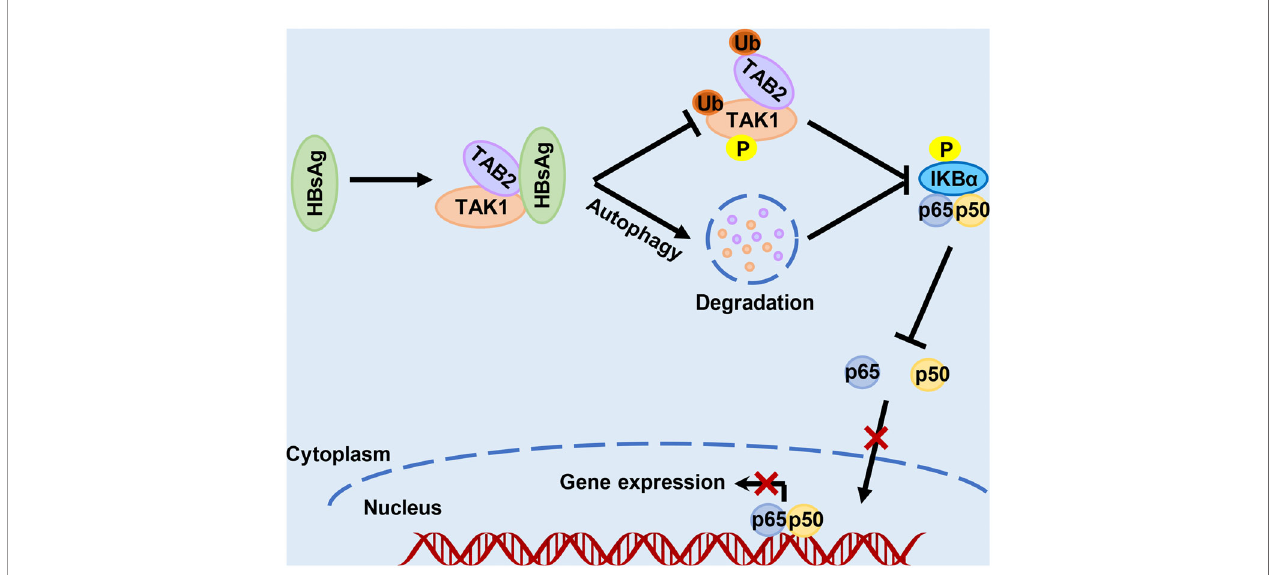
FIGURE 8 | Schematic illustration of how HBsAg interferes with the nuclear factor kappa B (NF- k B) signaling pathway. HBsAg speci fi cally binds to TAK1 and TAB2, suppresses the polyubiquitination of TAK1-TAB2 complex, blocks TAK1 and IKB a phosphorylation, inhibits the NF- k B subunits p50 and p65 translocation from cytoplasm to nucleus, and downregulates the expression of IFNs and in fl ammatory cytokines. On the other hand, HBsAg interferes the molecular interaction between TAK1 and TAB2 with promoting autophagic degradation, further inhibiting the activation of NF- k B signaling